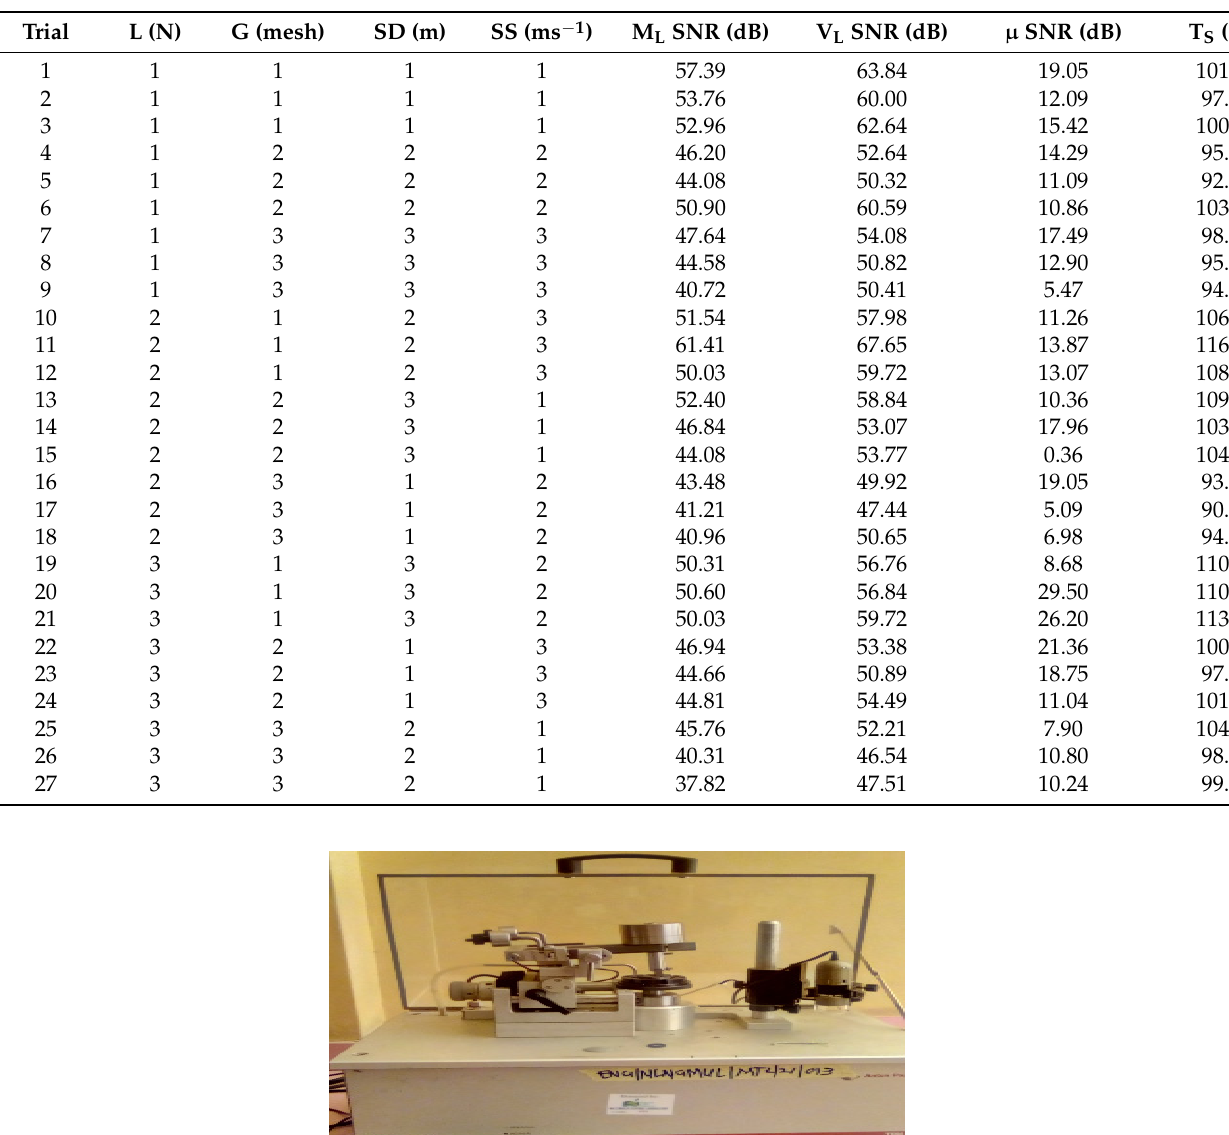
Figure 3. Taguchi L (cid:2870)(cid:2875) (3 4 ) OA. Table 3. Signal noise ratio of against SiC particle based on Taguchi L (cid:2870)(cid:2875) (3 4 ) OA. Trial